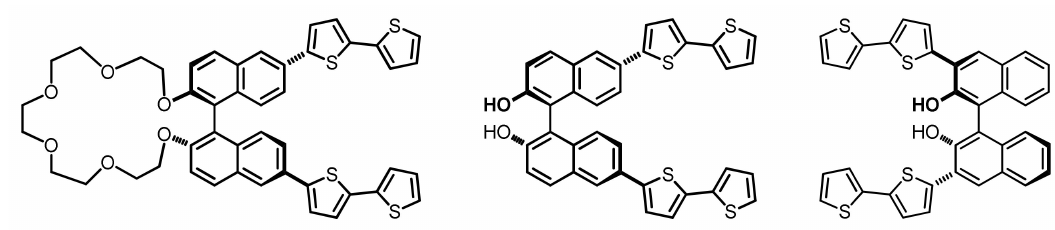
Figure 3. Examples of chiral electroactive monomers based on